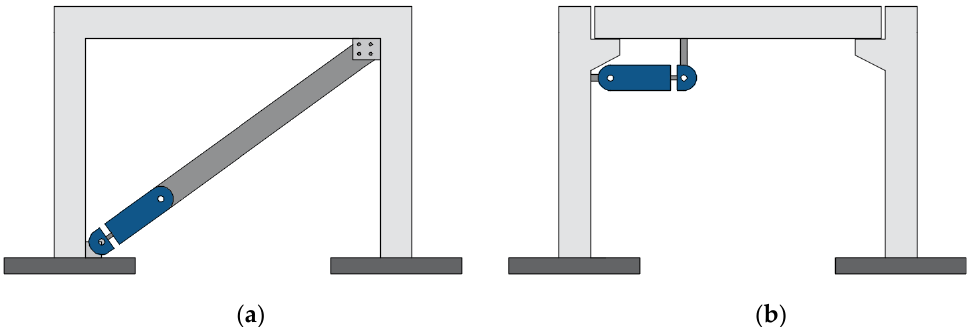
Figure 3. Possible configurations of installation of the PS-LED on frame structures: ( a ) brace configuration; ( b ) beam – column joint configuration.